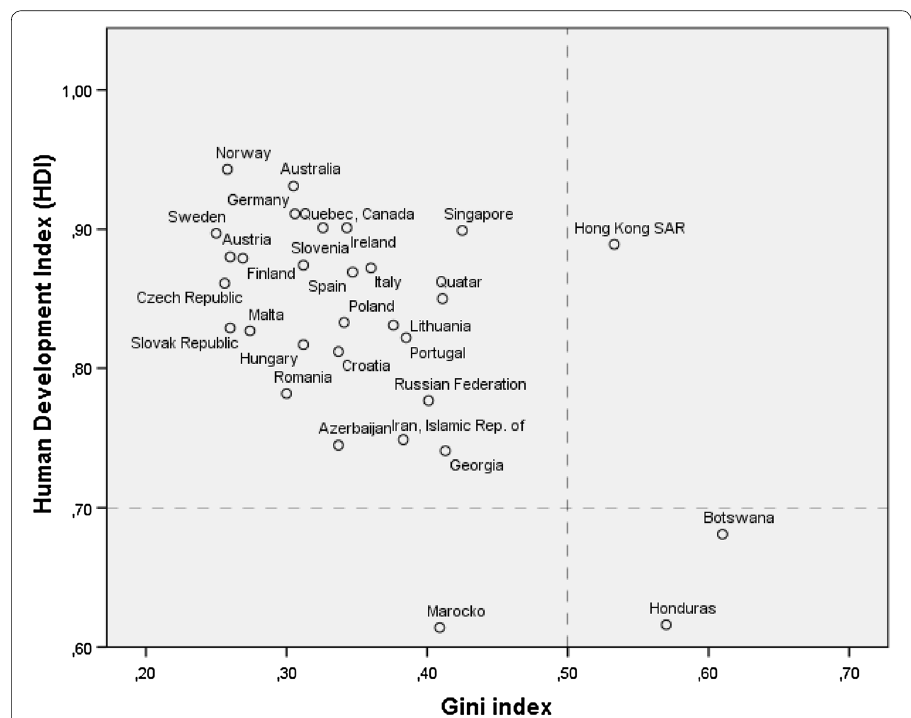
Fig. 1 Scatter plot of the relations between the Gini index and the